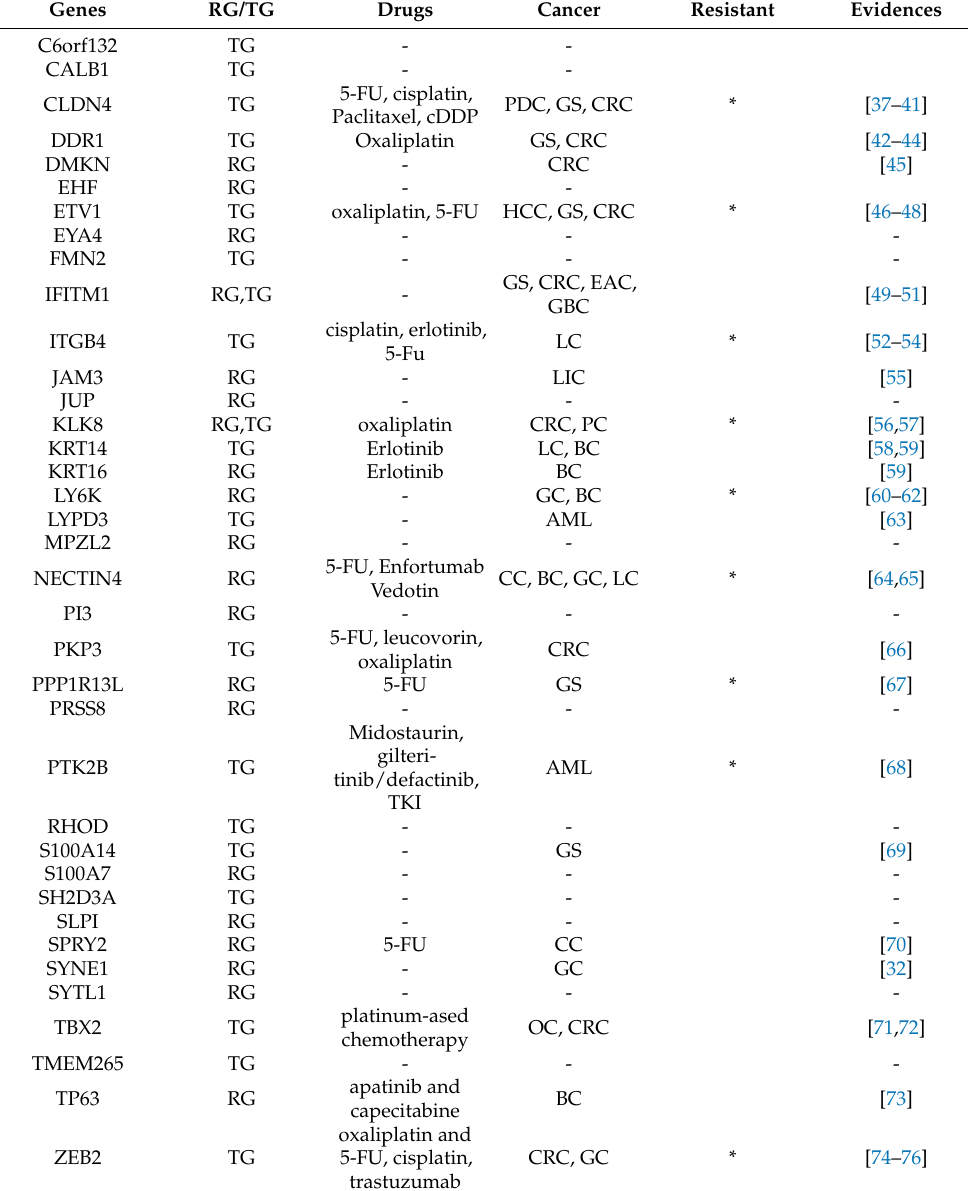
Table 2. Identified markers and their